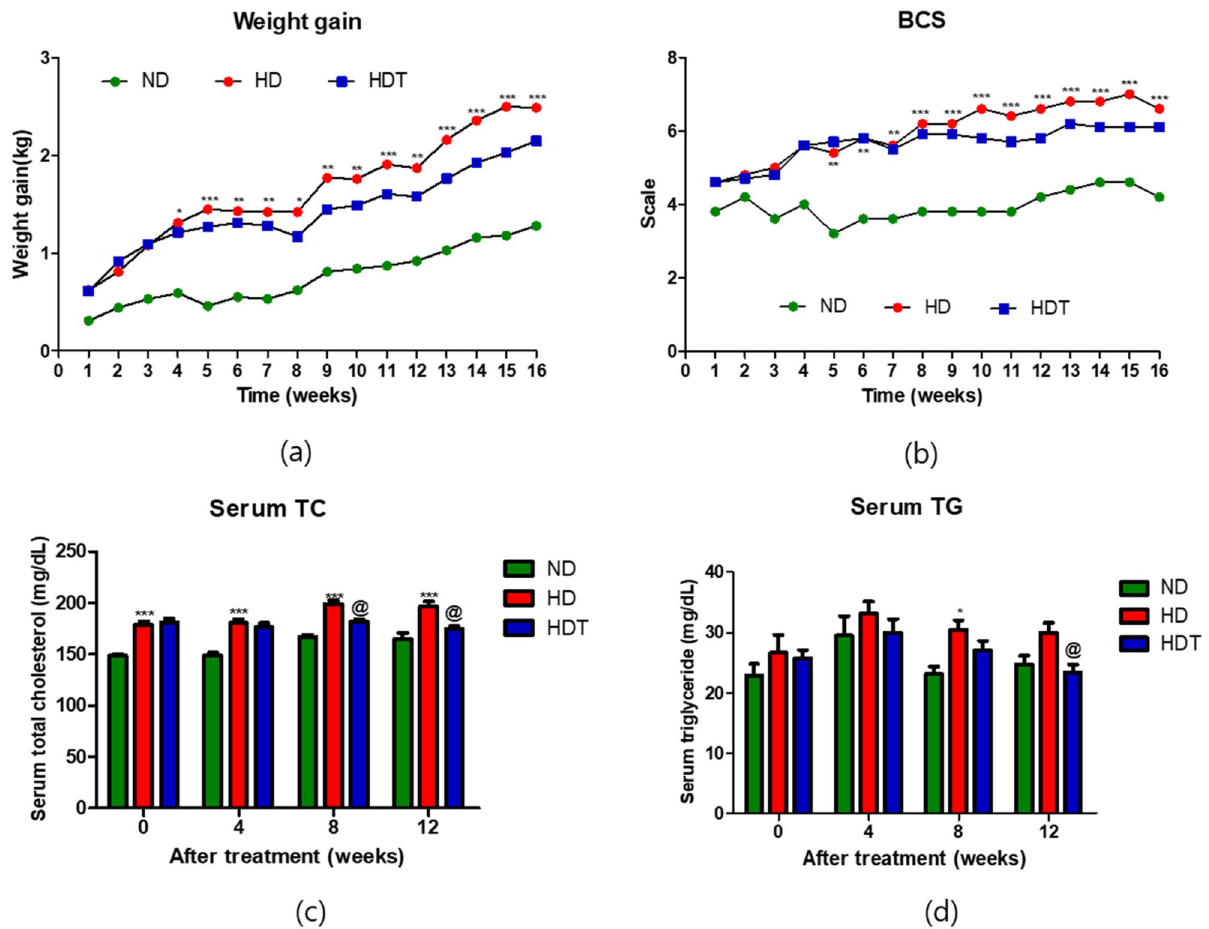
Figure 1. Comparison of weight gain, body condition score (BCS), serum TC, and TG in overweight beagle dogs with BG&SW supplements treatment. ( a ) Weight gain. ( b ) BCS. ( c ) Serum TC. ( d ) Serum TG. *p < 0.05, **p < 0.01, and ***p < 0.001 vs. ND. @ p < 0.05 vs. HD. ND normal diet group, HD high energy intake group, HDT high energy intake with BG&SW supplements treatment group. P ND HD HDT SEM